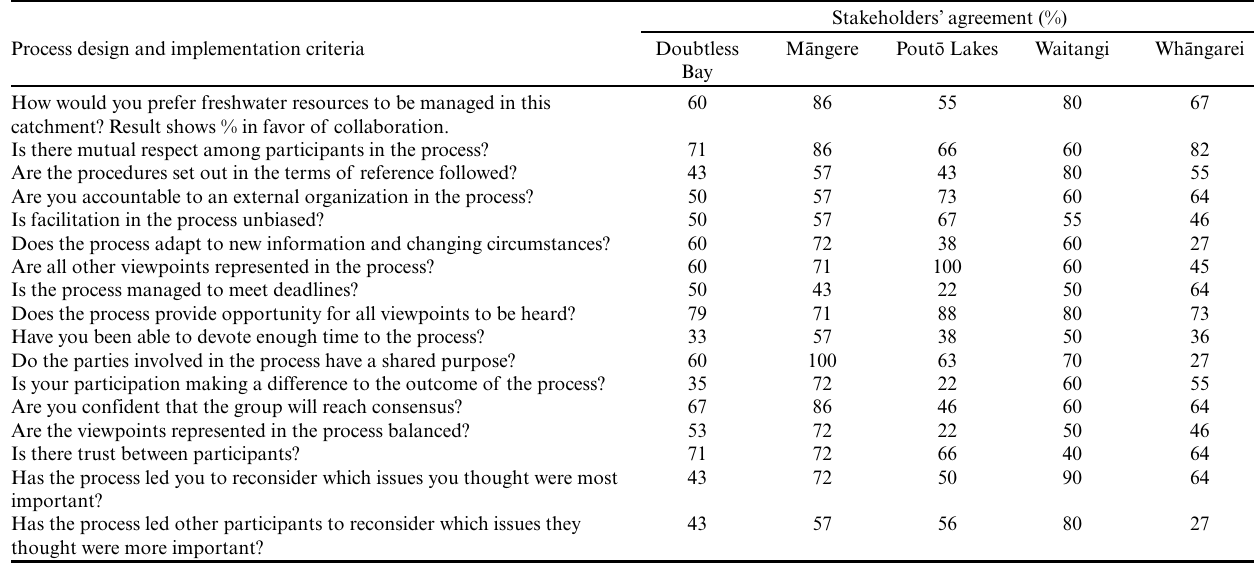
Table 6 . Selected process design and implementation criteria statements and stakeholders’